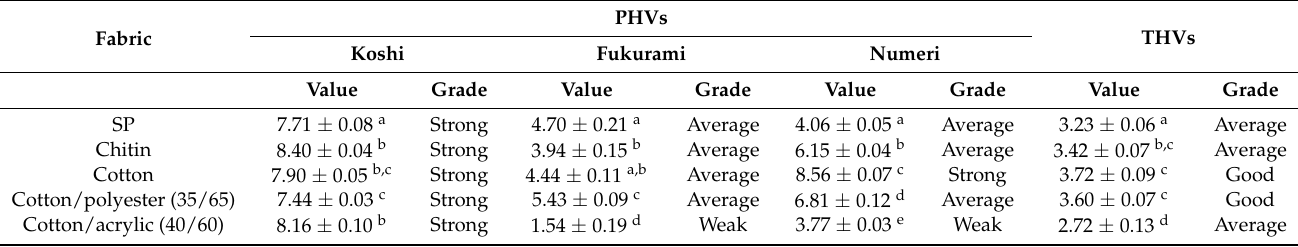
Table 8. Results obtained through Kawabata of the primary and total hand values (PHVs and THVs) of men’s winter suit fabrics of soy protein (SP), chitin, cotton, and cotton-based fibers. Fabric